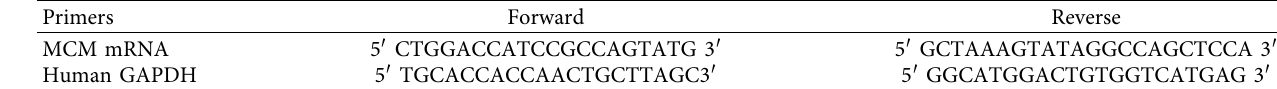
Table 1: Primers used in the current